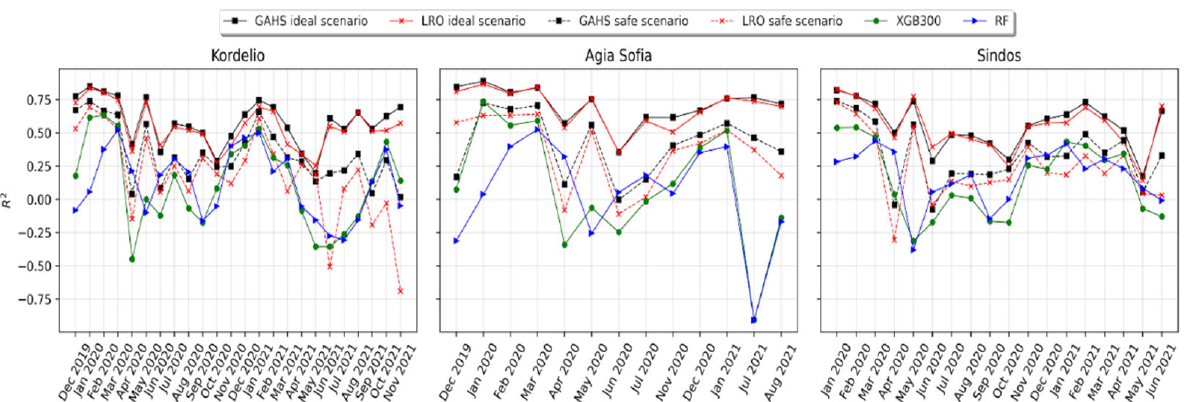
Figure 12. Comparison between the GAHS and SOL frameworks and the best performing batch models in terms of the coefficient of determination for PM 10 .